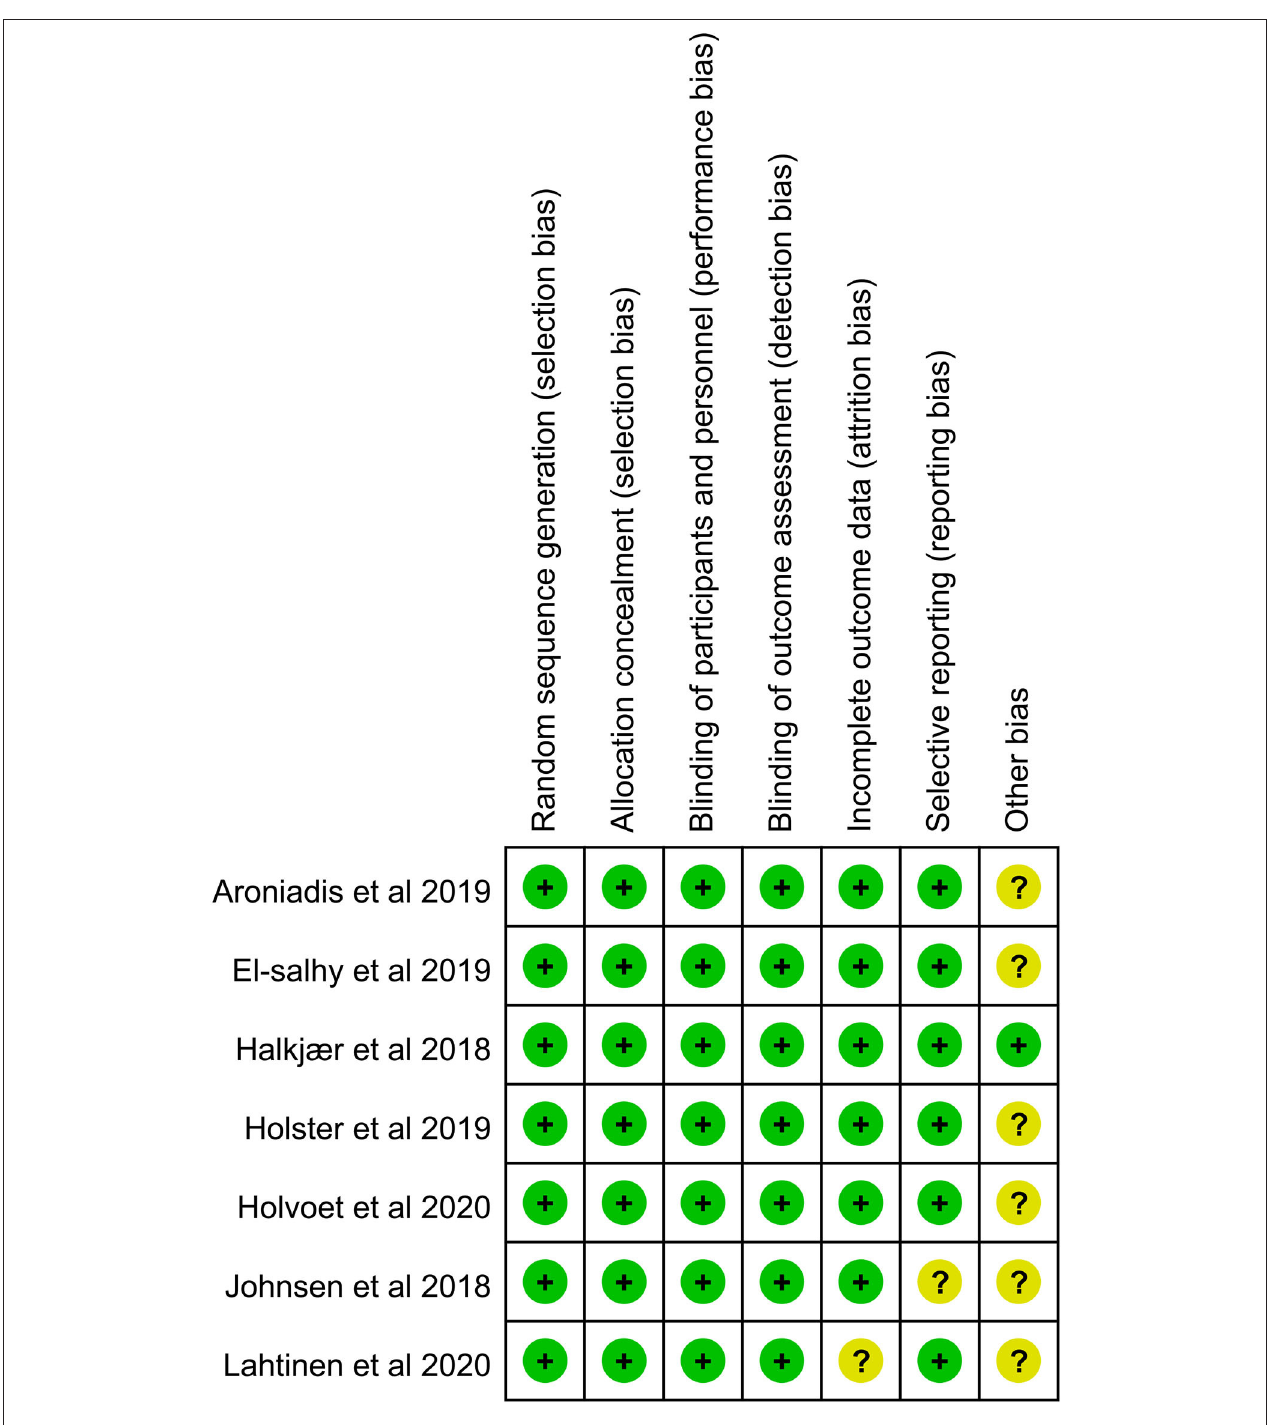
FIGURE 2 | Risk of bias